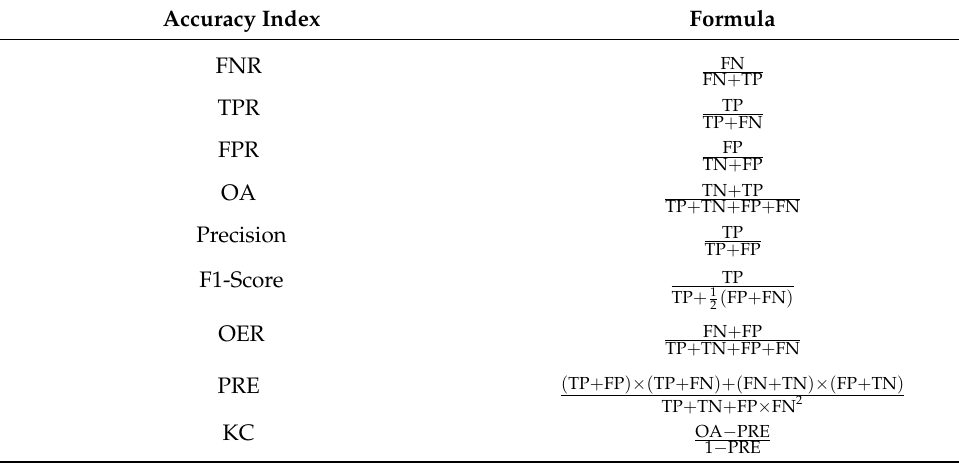
Table 1. Formulas for accuracy assessment